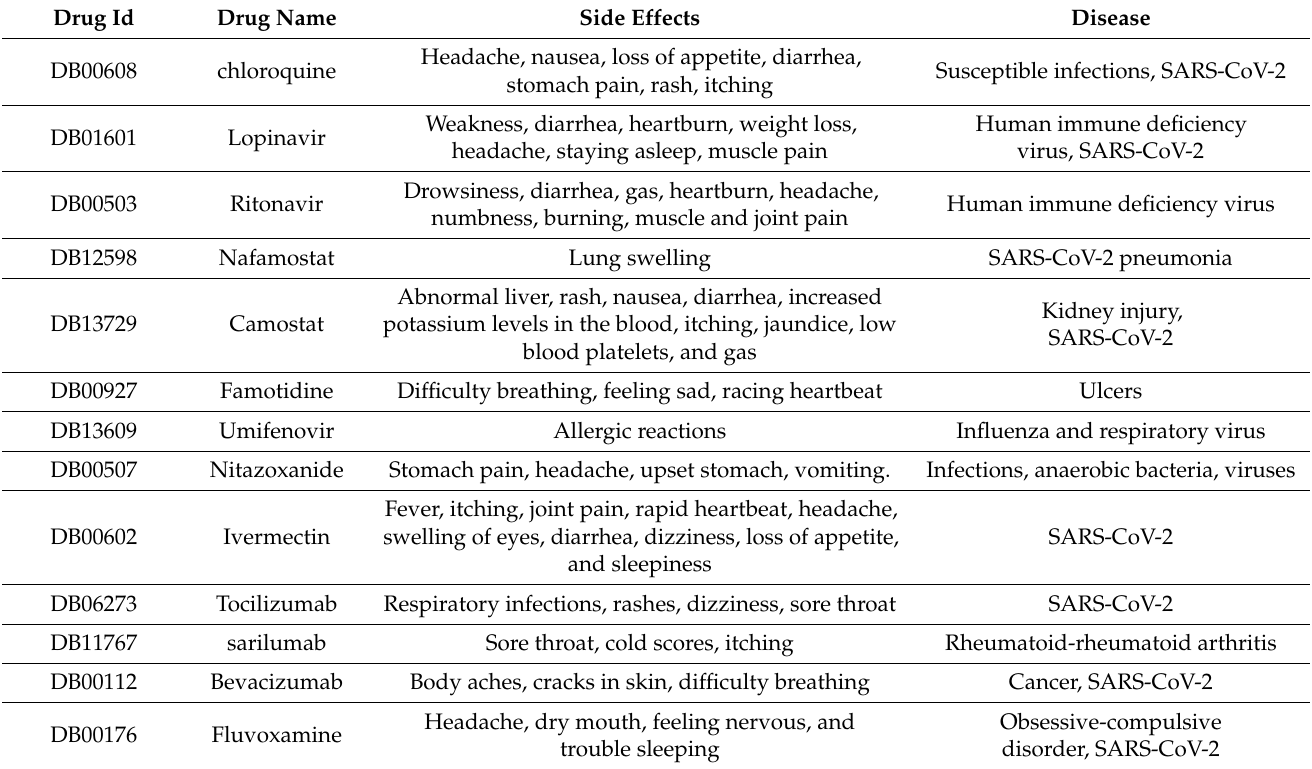
Table 2. Predicted drugs for specific diseases with the side effects.